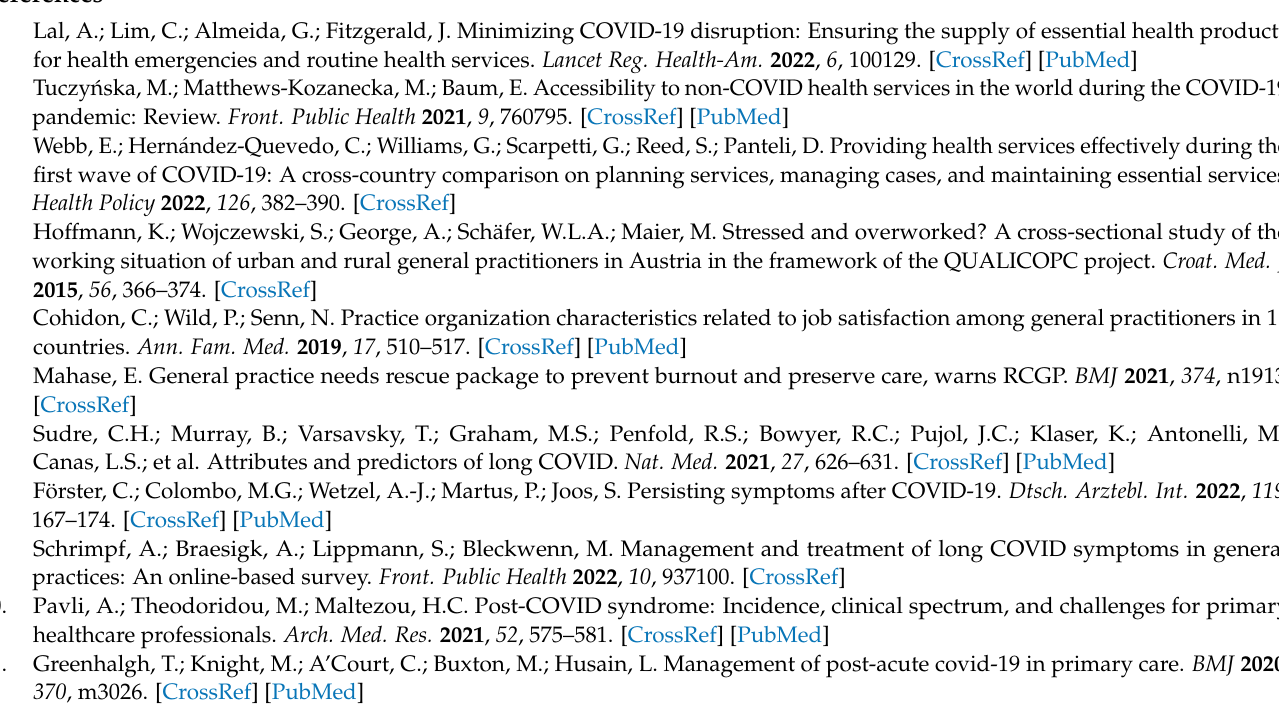
Table S3: Characteristics of participating GPs at baseline and follow up (GPs in the follow-up survey also participated in the baseline survey); Table S4: Other problems and needs related to the treatment of patients with COVID-19 or long COVID: content analysis of free text answers at baseline 2021; Table S5: GPs’ reasons for wanting to leave their job ( n = 13): content analysis of free text answers; Table S6: GPs’ general comments on long COVID at baseline 2021 ( n = 33): content analysis of free text